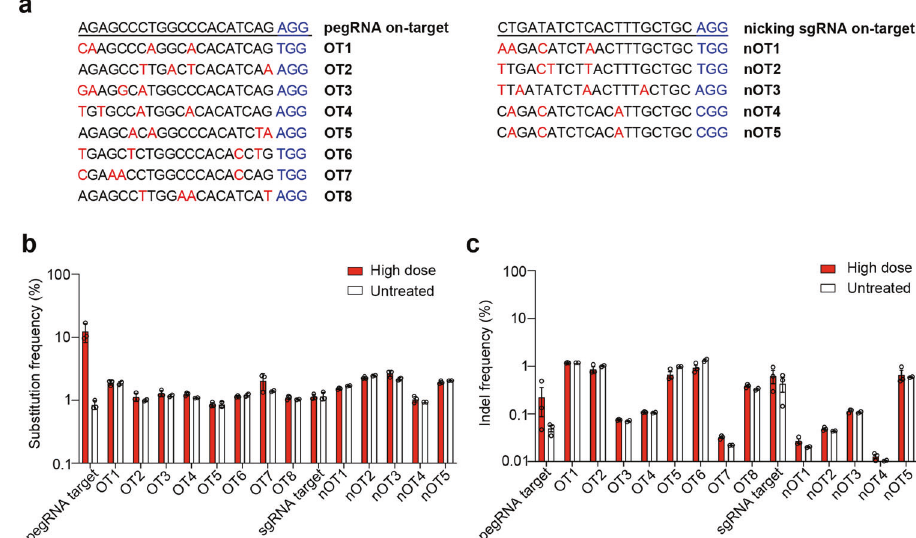
Fig. 4 PE3 corrects the pathogenic mutation in a highly precise manner. a Potential off-target sites of pegRNA and nicking sgRNA computationally predicted by CRISPOR. Red indicates mismatched sequences, while blue represents PAM sequences. Frequencies of the substitution ( b ) and indels ( c ) at the eight potential off-target sites of pegRNA (OT1 – OT8) and at the fi ve potential off-target sites for nicking sgRNA (nOT1 – nOT5) in RPE tissues of untreated ( n = 2 – 3) and high-dose treated ( n = 3) rd12 mice. A 40-bp region centered on the pegRNA nicking site was used to assess substitutions near the targeted nucleotide. A 100-bp region centered on the pegRNA nicking site was used to assess indels. Data are mean ±